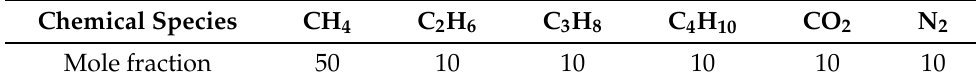
Figure 1. Computation flow of Parametric Equation Formalism. Table 2. Assumed composition of model associated petroleum gas